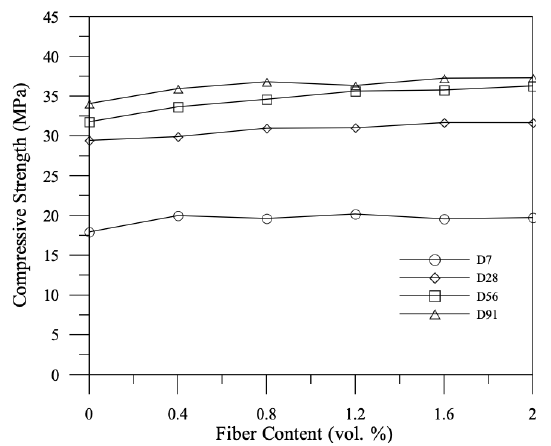
Figure 1. Compressive strength development curves of polyolefin fiber concrete without slag.